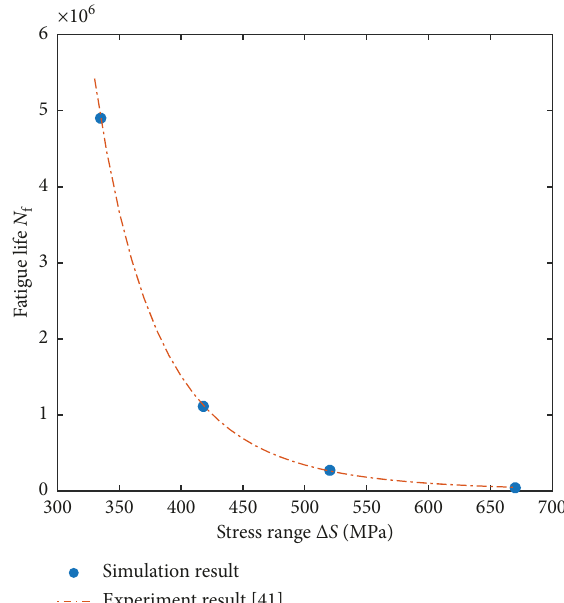
Figure 11: The S-N curve of the undamaged steel wire under the uniaxial tensile fatigue